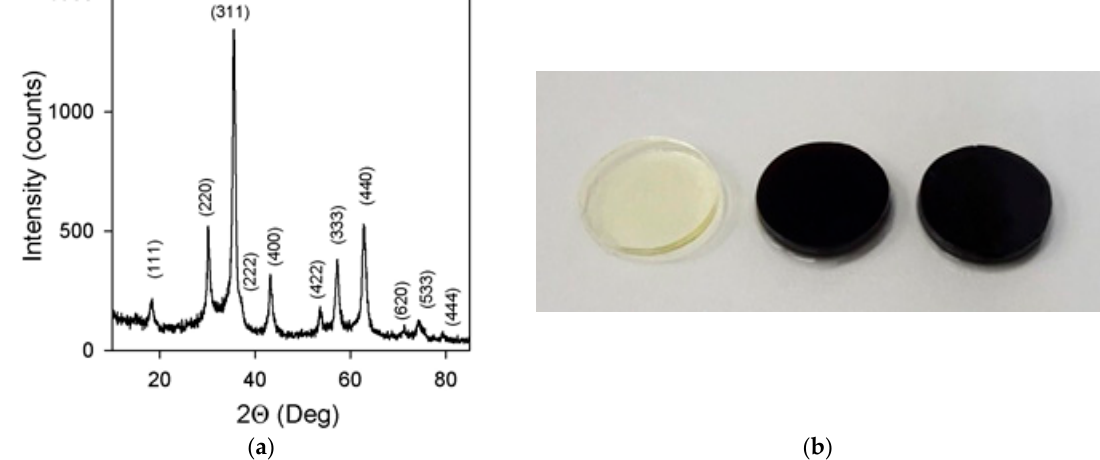
Figure 6. ( a ) XRD pattern of iron oxide MNPs with Miller indexes for the inverse spinel lattice of magnetite (or maghemite). ( b ) Gel samples used for cells culturing (from left to right): BG, FG1, FG2. Diameter of gel samples is 13 mm.